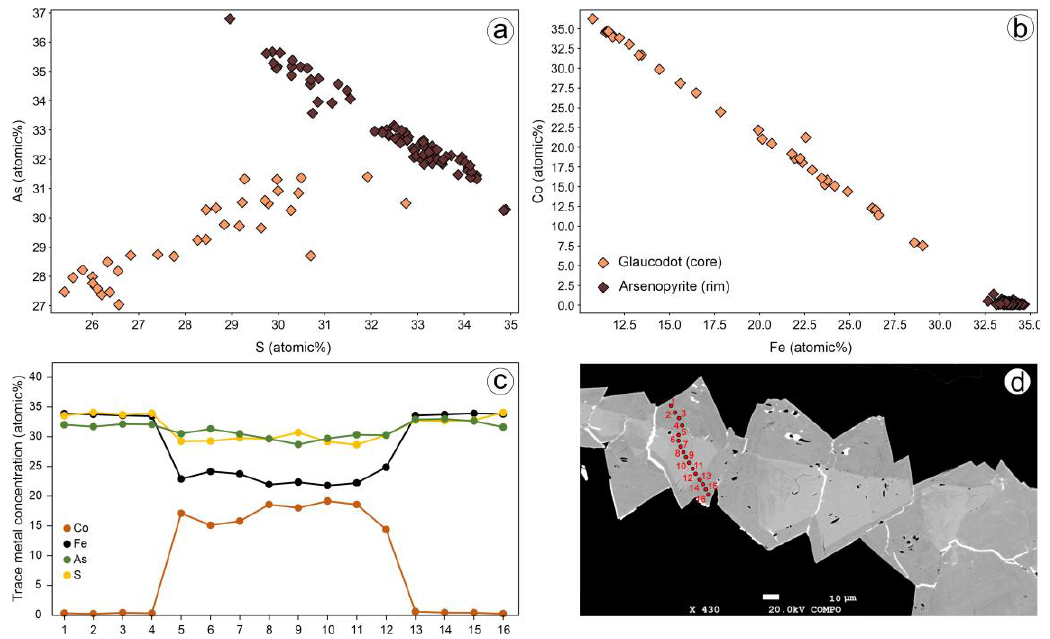
Figure 8. Binary plots of S versus As ( a ) and Fe versus Co ( b ) as well as traverse point analysis ( c , d ) to identify compositional variation in arsenopyrite – glaucodot. identify compositional variation in